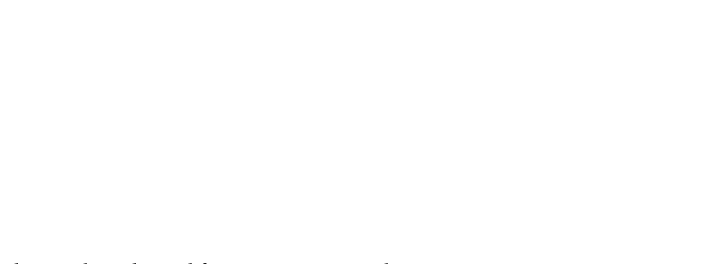
Table 1. Lifetime of ClpXP-mediated proteolysis derived from SDS-PAGE